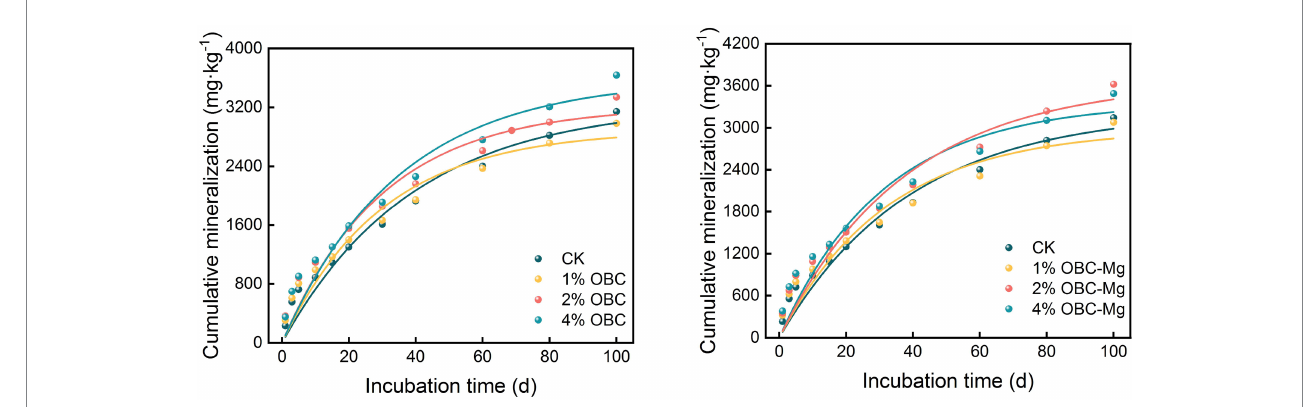
FIGURE 7 Changes in soil cumulative mineralization after the amendment of OBC and OBC-Mg.